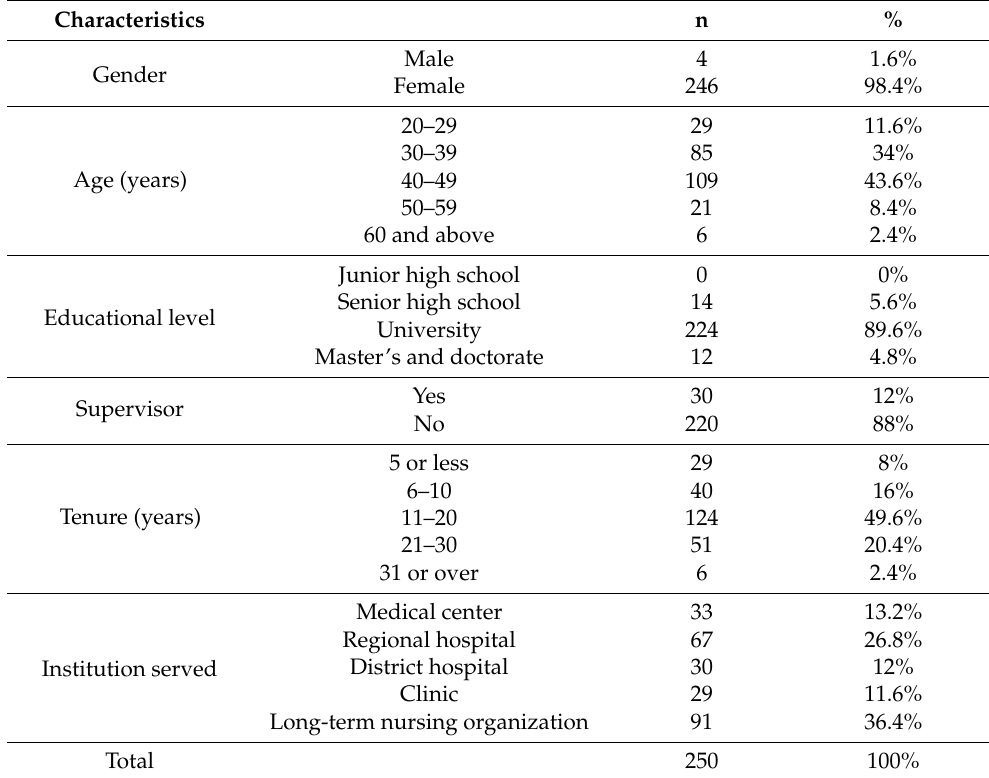
Table 1. Participants’ demographic